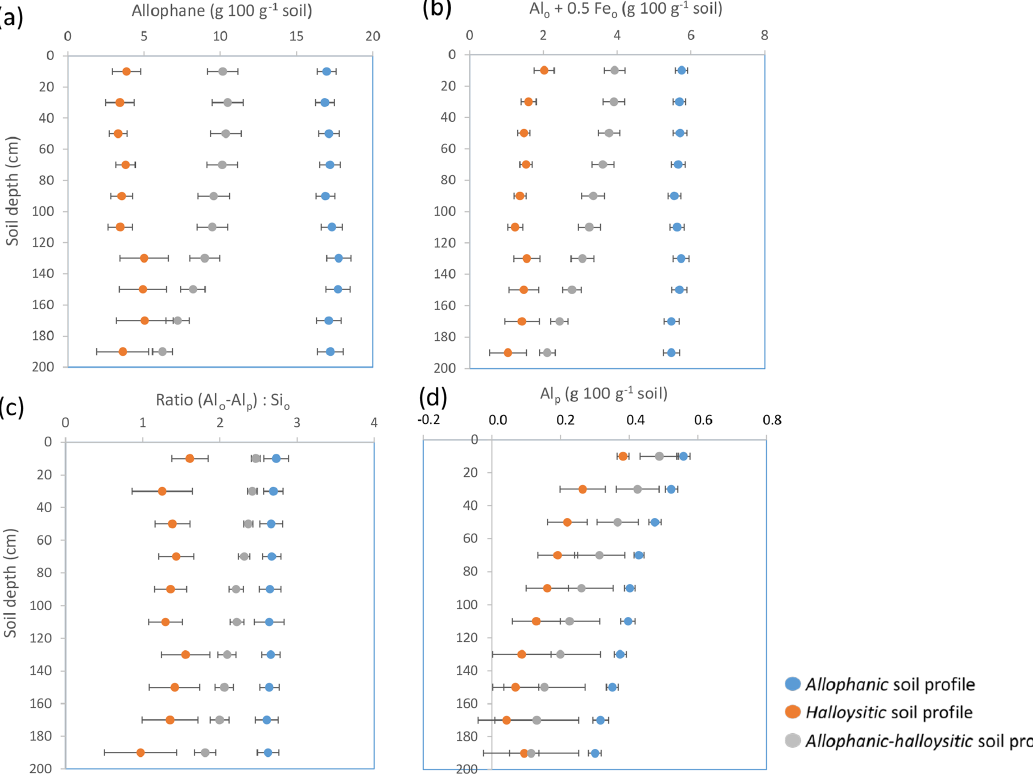
Figure 3. The three types of soil profiles, according to four characteristics of andic soils ( a allophane content, b Al o + 0 . 5Fe o index, c Al : Si ratio, and d organo-Al complexes or Al p content). The allophanic soil profile shown is the mean soil profile of 35 soil profiles; the halloysitic soil profile is the mean soil profile of 8 soil profiles and the allophanic – halloysitic soil profile is the mean soil profile of 26 soil profiles. Error bars are error types.